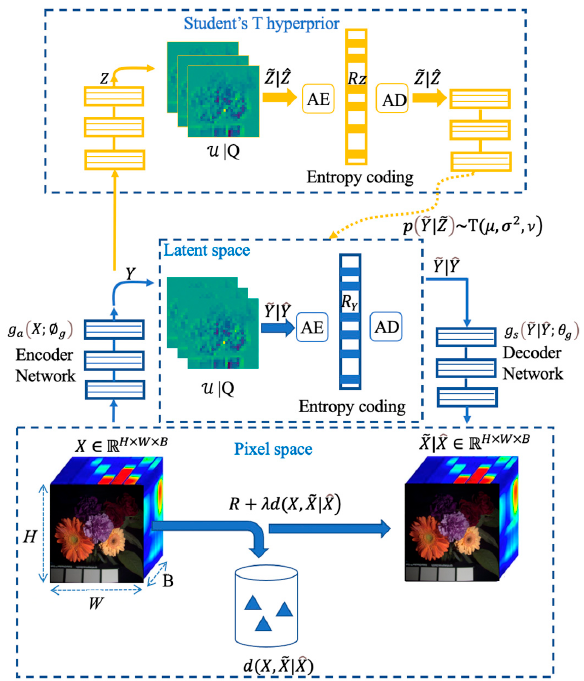
Figure 4. An end-to-end HSI compression model with the Student’s T hyperprior. U |Q corresponds to either additive uniform noise employed during training (yielding vectors signed with a tilde) or rounding during testing (yielding vectors signed with a hat). The architecture of the hyperprior is identical to [30], except that we use a Student’s T likelihood. The details of g a and g s are specified in Section 3.3.